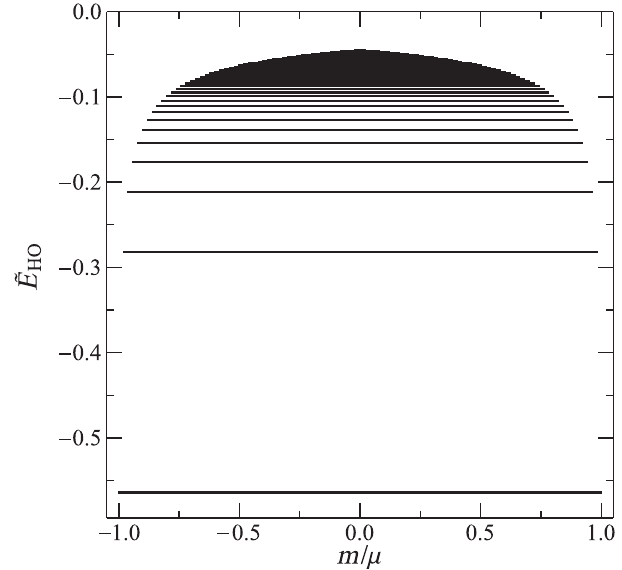
FIG. 9. The μ ¼ 100 eigenspectrum for a 2D SQD composite in the d → 0 limit. The oscillator frequency is set to ω ¼ 1